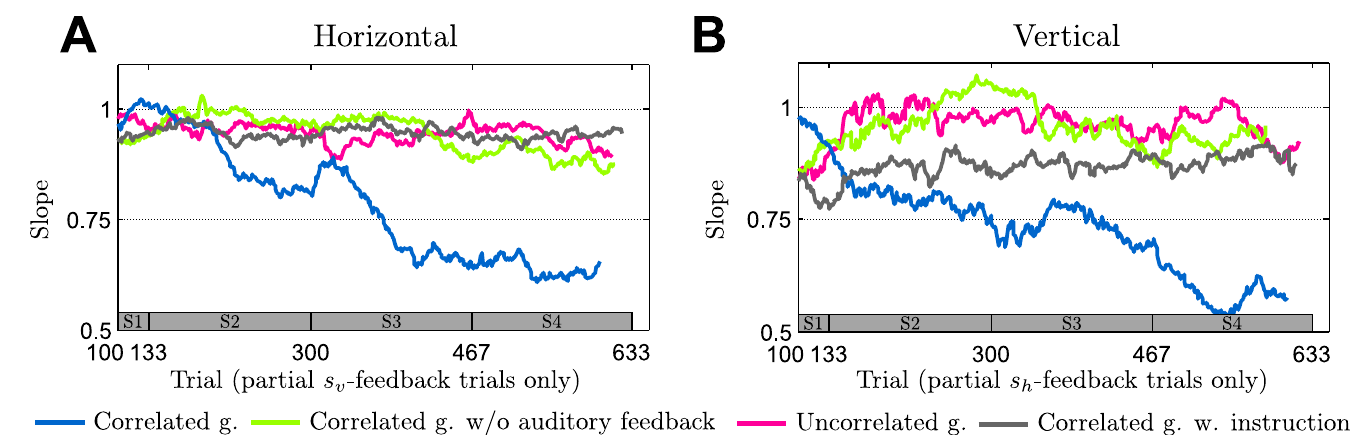
Fig 9. Changes in slope in partial feedback trials across groups. The slope is determined as in Fig 6. A Evolution of the horizontal slopes in partial s v feedback trials where horizontal information is not given by the feedback, but can only be obtained through knowledge of the correlation structure. B Evolution of the vertical slopes in s h feedback trials where vertical information is not given by the feedback, but can only be obtained through knowledge of the correlation structure. The correlated group shows a gradual and steady improvement across sessions whereas the other groups do not show such a trend. Different colored lines show the median over the different groups of participants and can vary in length since the exact number of relevant trials could fluctuate due to the probabilistic generation of trials. The bar at the bottom of the figure indicates the corresponding session (on